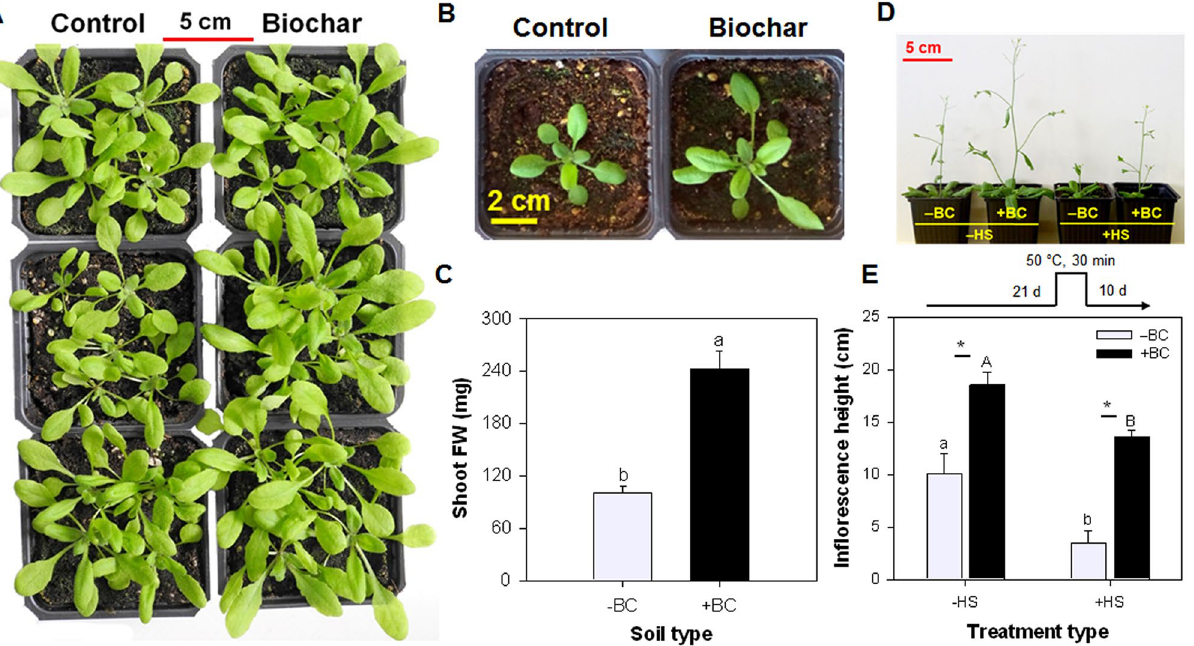
Figure 1. Effect of absence ( ‒ BC or Control) and presence (+ BC or Biochar) of biochar on Arabidopsis thaliana seedlings growth. ( A ) Plant growth; ( B ) Rosette growth; ( C ) Shoot fresh weight after 21 d of seed germination; (D) Inflorescence height in plants in ‒ HS and + HS conditions at 21 days and grown for additional 10 days. Images of plant growth and rosette growth were captured after 21 d and inflorescence height was captured after 31 d of seed germination. Data are representative of multiple repeated experiments. Columns (n = 3; means ± S.E.) labeled by a different letter in Figure C are significantly different at p ≤ 0.05. Columns (n = 3; means ± S.E.) labeled by different lowercase and uppercase letters in Figure E are significantly ( p < 0.05) different within the ‒ BC and + BC groups and in ‒ HS and + HS treatments, respectively. Asterisk denotes significant difference at p ≤ 0.05 according to Tukey Kramer HSD test between –BC and + BC at a given heat treatment.